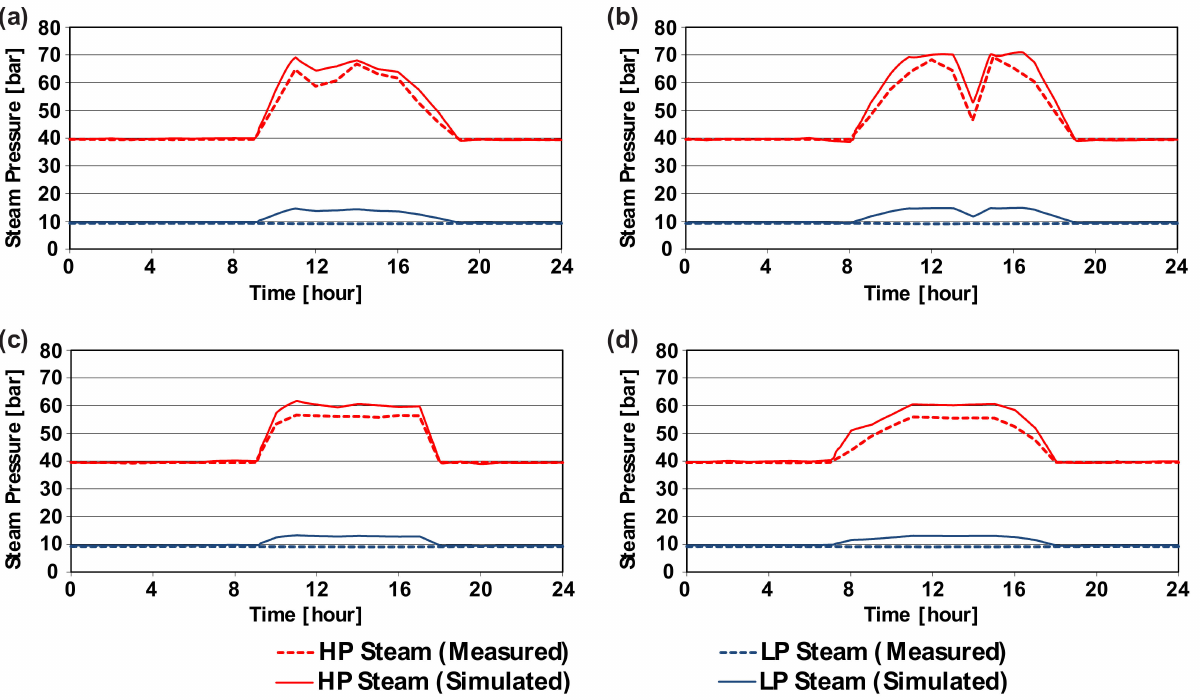
Figure 10. The steam pressure before the steam turbines for four days: ( a ) 20 July 2013; ( b ) 21 July 2013; ( c ) 30 August 2013 and ( d ) 4 September